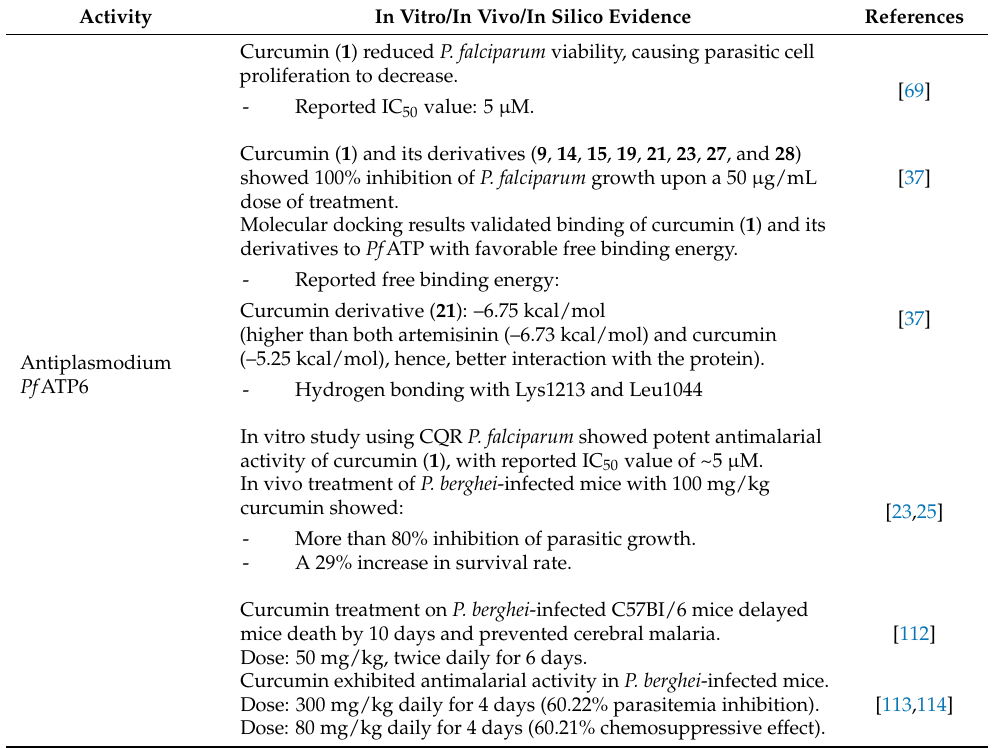
Figure 22. Examples of potential parasite target proteins involved in the pathophysiology of malaria. Table 4. Antimalarial and anti-inflammatory activities of curcumin and its derivatives.